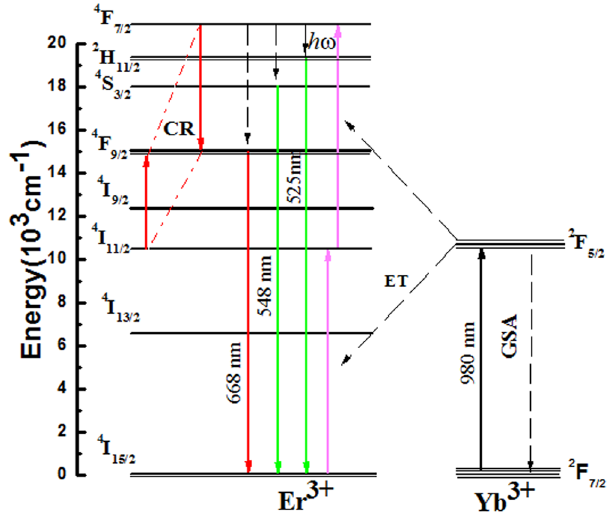
Figure 6. Energy level diagram of Er 3 + /Yb 3 + and energy transfer